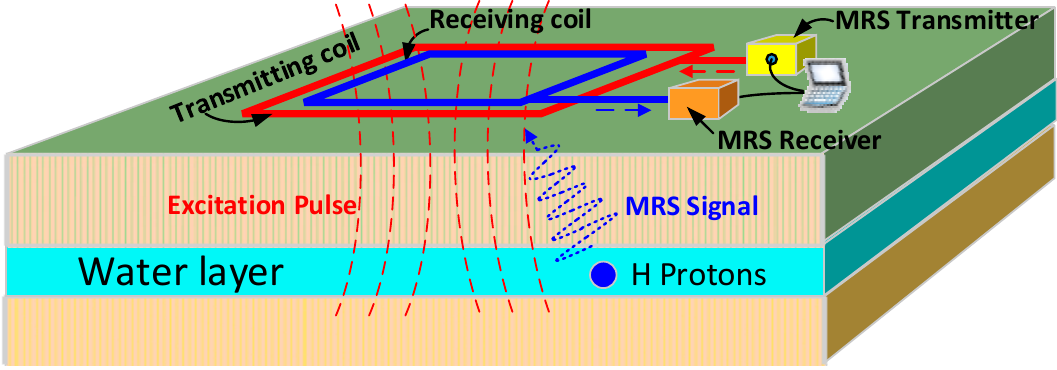
Figure 1. Schematic diagram for detection of magnetic resonance sounding (MRS)